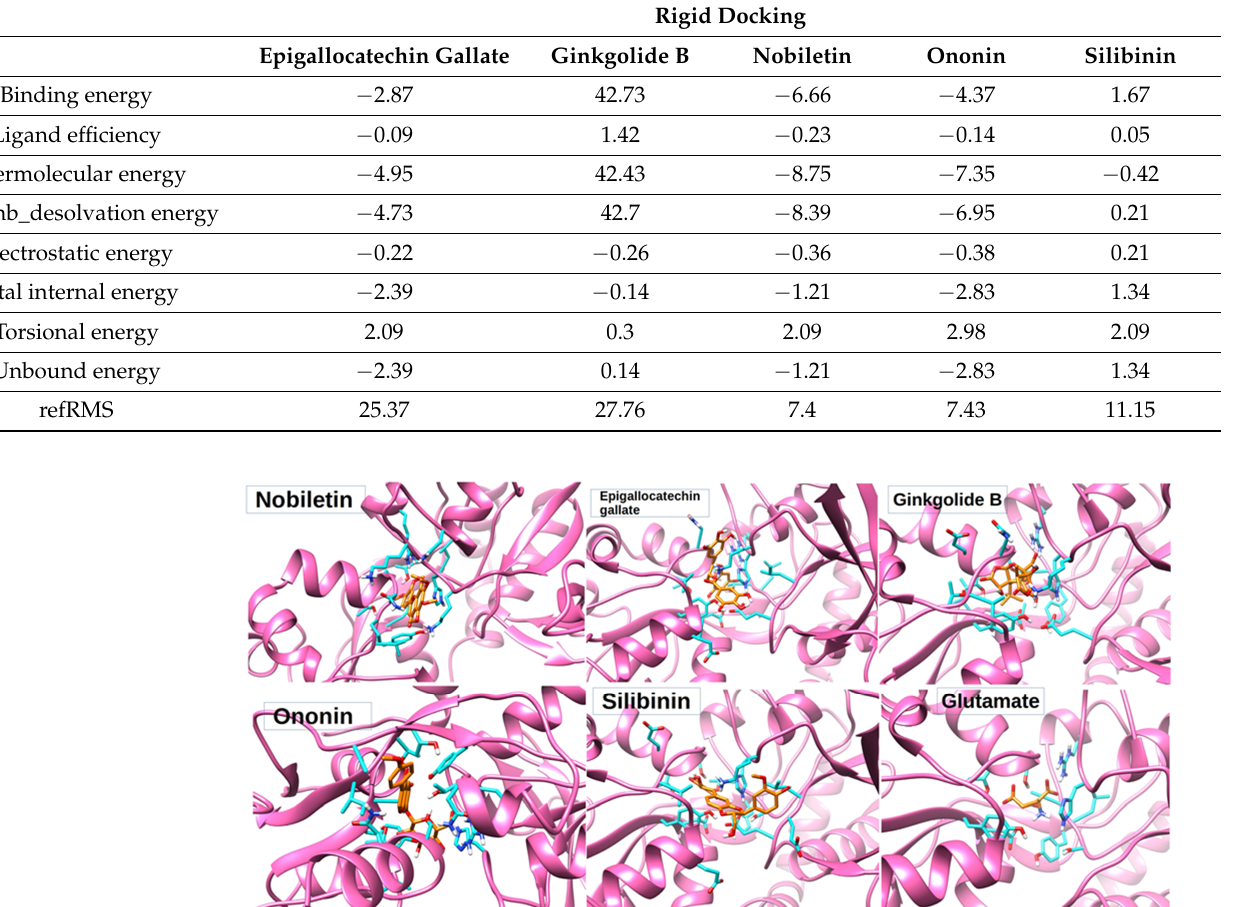
Table 2. Docking scores of nobiletin, ginkgolide B, silibinin, ononin, and epigallocatechin gallate poses with NMDA receptor after rigid docking, as mentioned below.